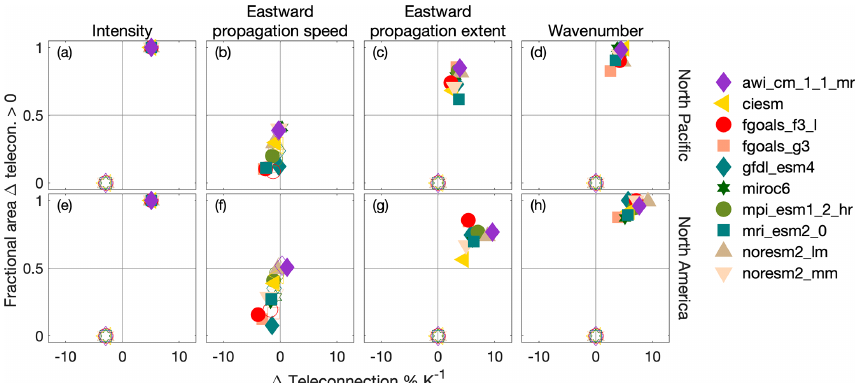
Figure 7. For individual CMIP6 model mean states, the change in the teleconnection amplitude (as a percent change per multi-model mean kelvin warming) to the North Pacific (25–70 ◦ N, 150–235 ◦ E) and North America (25–70 ◦ N, 235–290 ◦ E) between LBM simulations with the control and perturbed thermal forcing. (a, e) Response to perturbed heating intensity, (b, f) eastward propagation speed, (c, g) eastward propagation extent, and (d, h) zonal wavenumber. Unfilled (filled) markers represent the lower (upper) bounds of perturbations to each MJO feature expected at the end of the century given a high-emissions scenario (see Table 1).